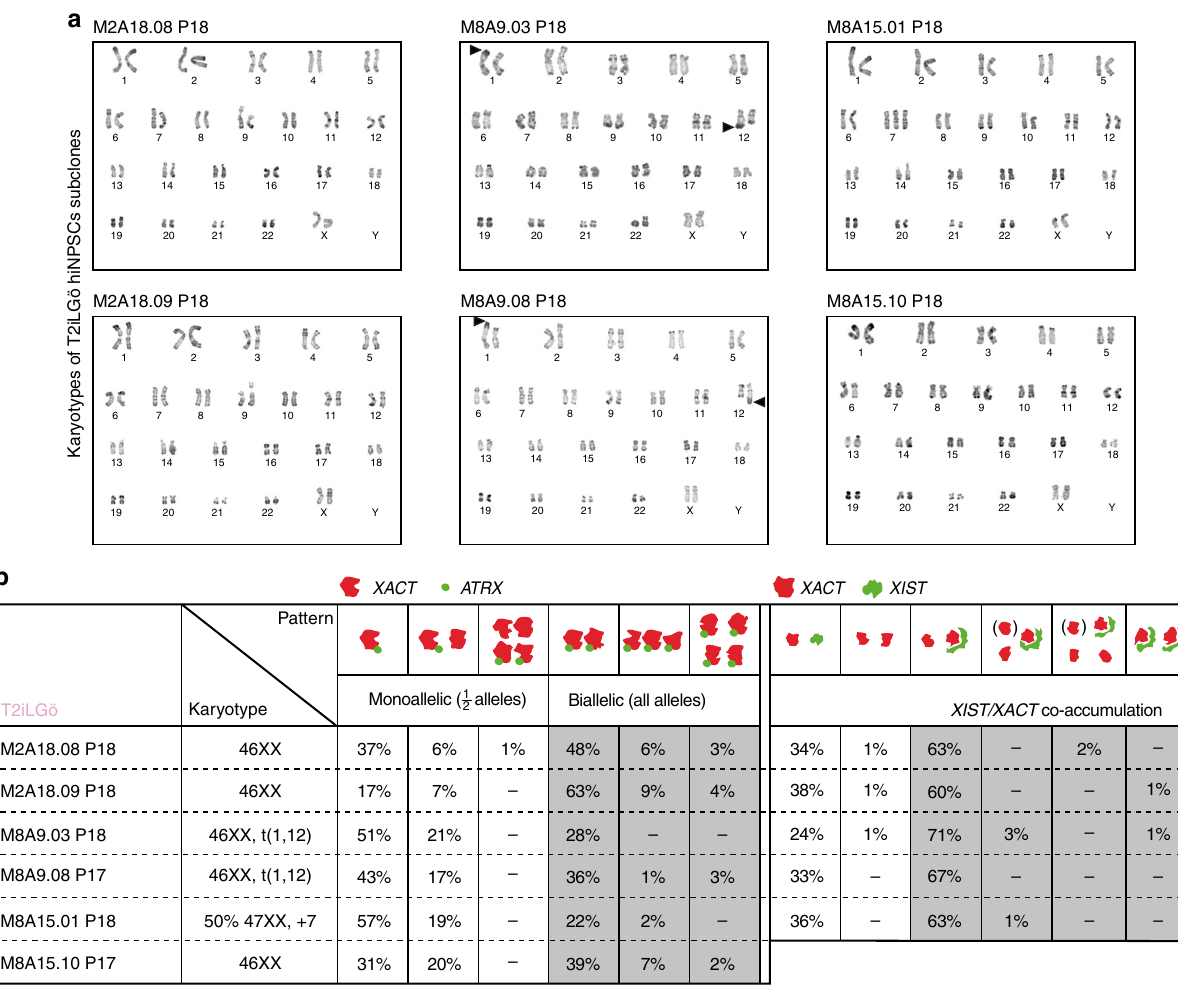
Fig. 6 Clonal analysis of X-chromosome reactivation in T2iLGö hiNPSCs. a Representative karyotypes of T2iLGö subclones. b Karyotype and mRNA FISH analysis for ATRX and XACT (left) or XIST and XACT (right) of indicated subclones. For each subclone represented, more than 50 cells were investigated for their nuclear expression of the indicated mRNA. Quanti fi cations for each combination are indicated below